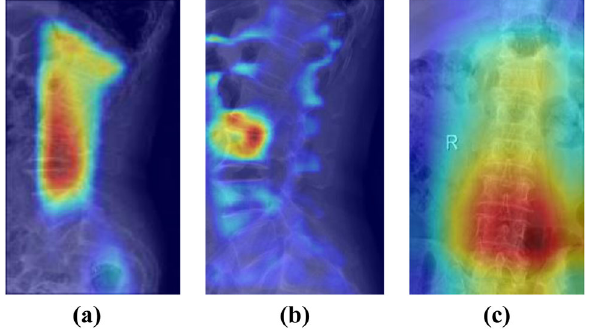
Fig. 15 Examples of the CAM of AEMONet on the lumbar spine dataset, and the red areas represent the discriminative regions learned by the neural network with BPAttLayer: a slight, b serious, and c